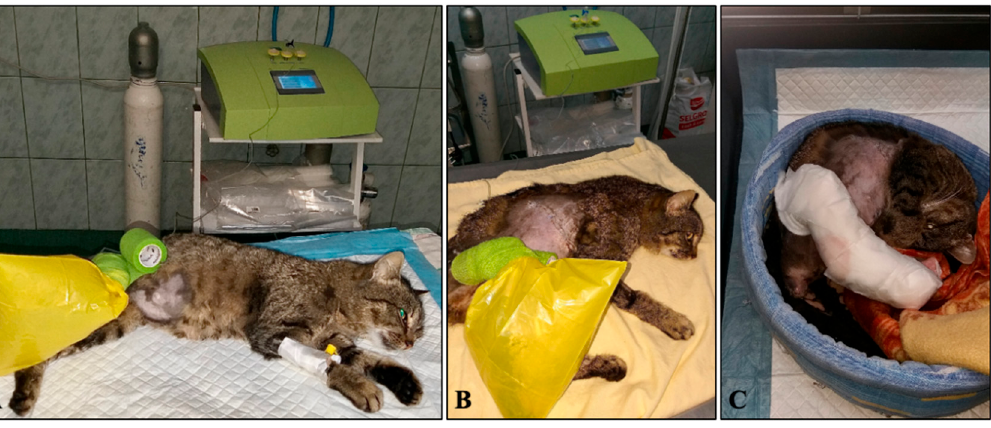
Figure 2. Ozone application. ( A )—First session. ( B )—Second session after the skin graft. ( C )—Dressing applied after skin graft. Table 1. Ozone therapy